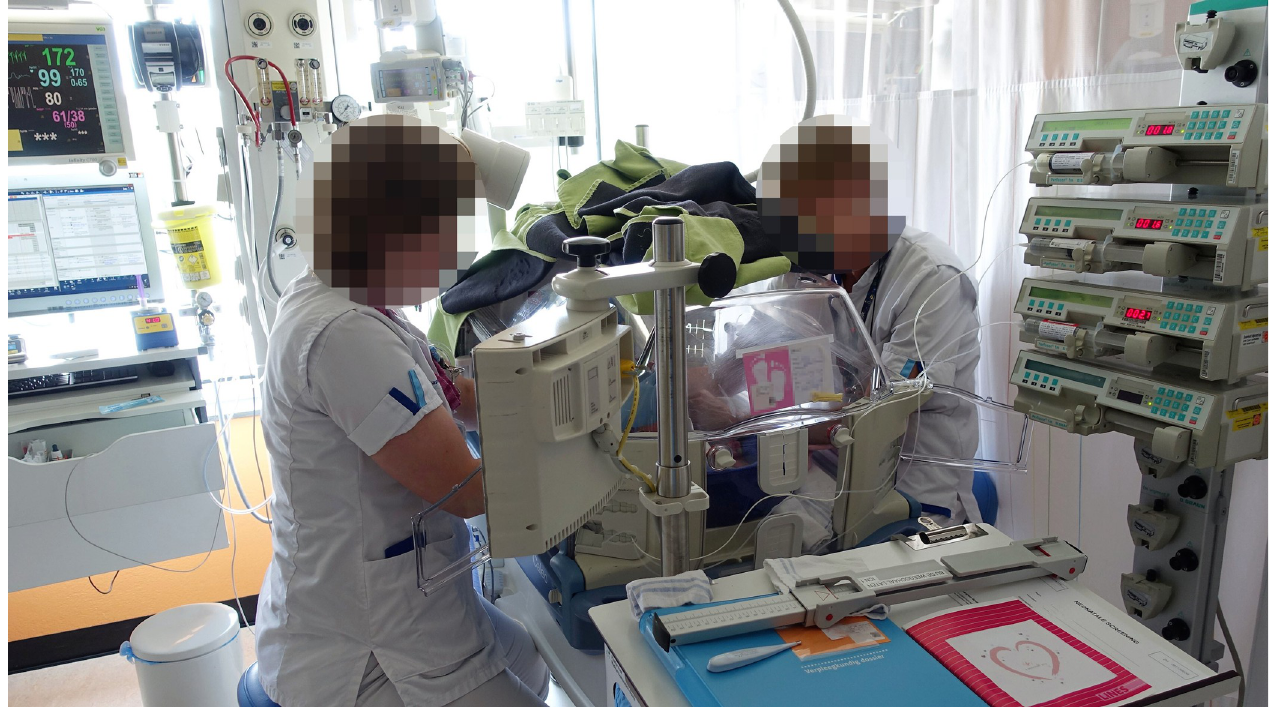
Fig 2. Growth reference charts are based on two parameters: Body length (BL) and head circumference (HC). As both BL and HC are expressed in centimetres with one decimal, measuring instruments with an accuracy of 1 mm are clinically sufficient.